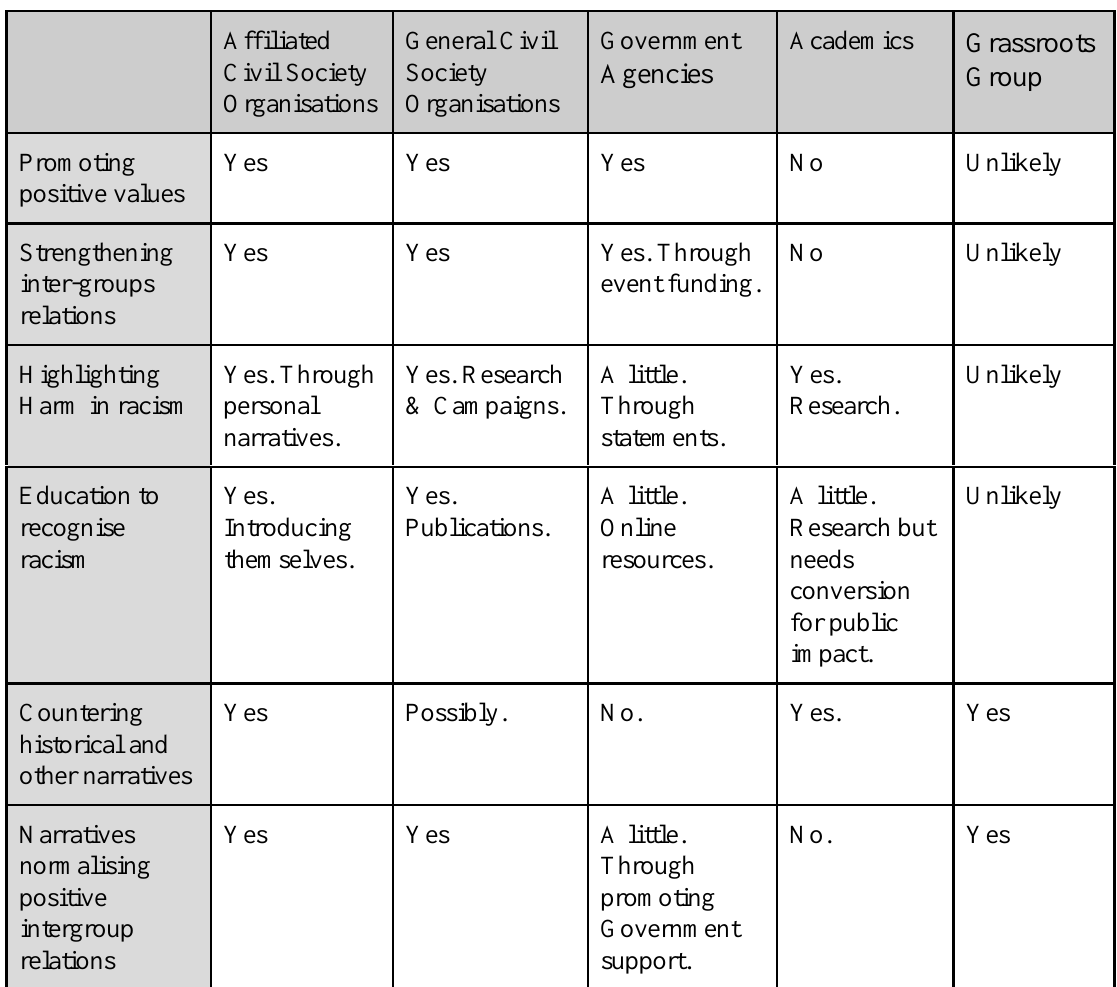
Table 2: Proactive modes of